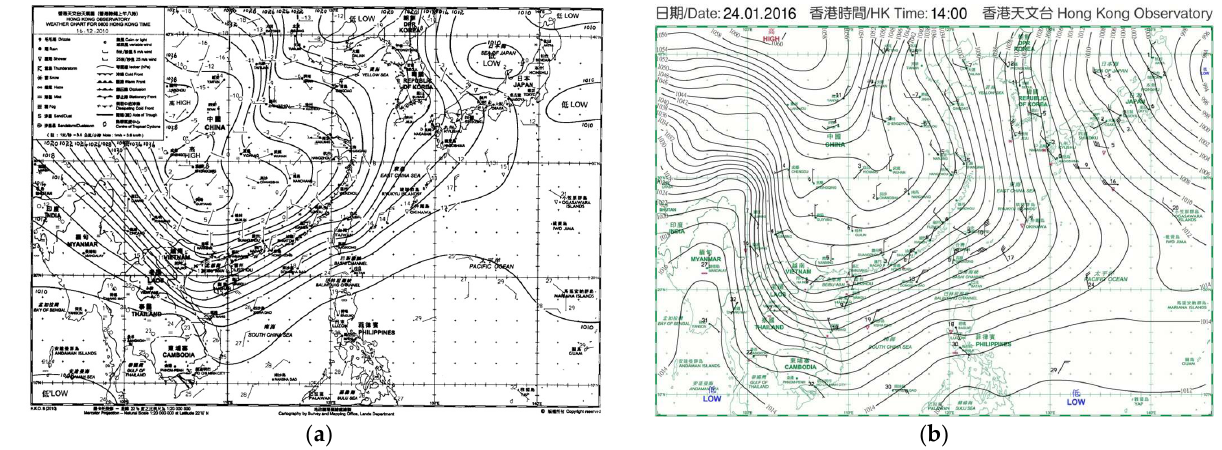
Figure 9. Surface analysis charts at: ( a ) 00 UTC on 16 December 2010; and ( b ) 06 UTC on 24 January 2016.